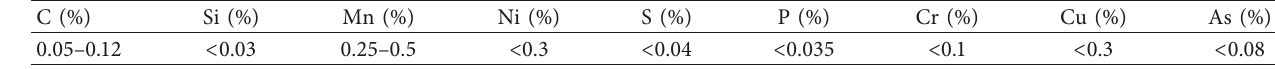
Table 1: The chemical composition of the material of the electrode tape.